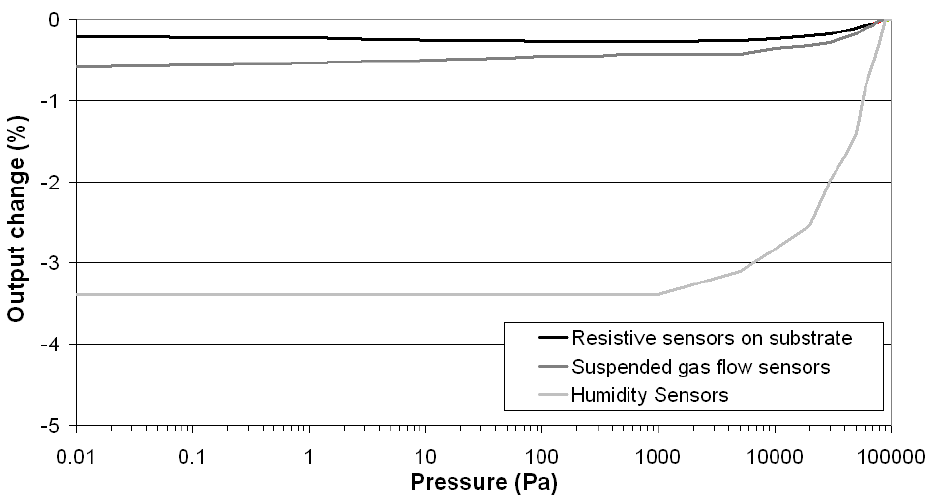
Figure 17. Influence of pressure on multisensor